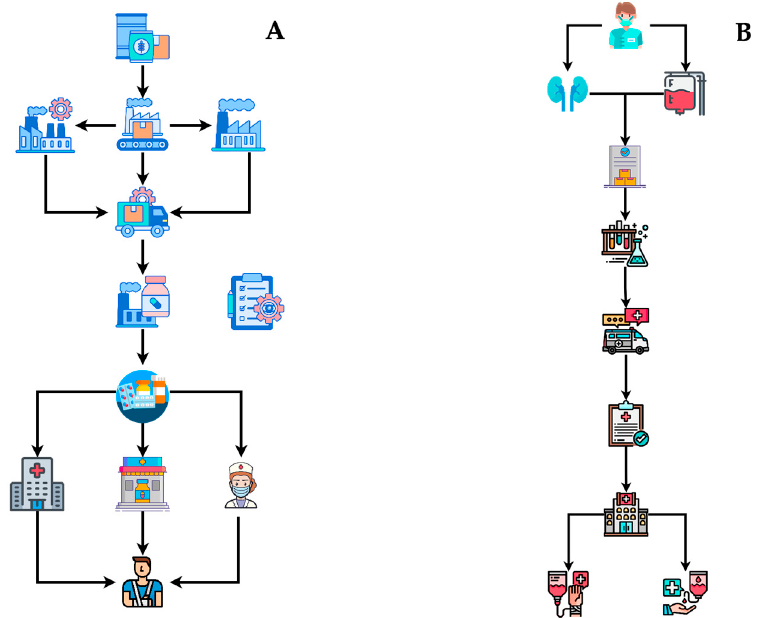
Figure 1. Steps of the supply chain in healthcare, specifically for DMDs ( A ) and BOTs ( B ). ( A ) A pharmaceutical SC’s general flow: from the raw material, to the manufactures, to the distribution to the pharmacies and hospitals, and to the patient; ( B ) general flow of BOT: from the donor to storage, transportation, quality check, and utilization for the patient.